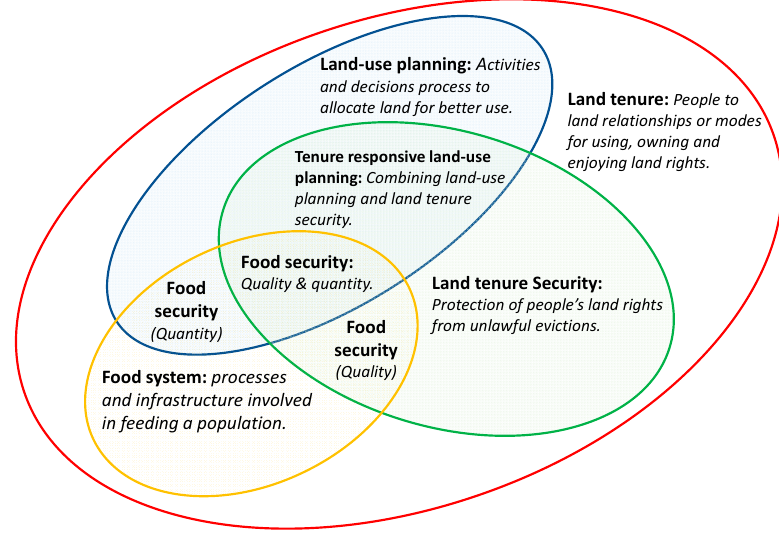
Figure 1. Conceptual delineation of key terms used in the study .